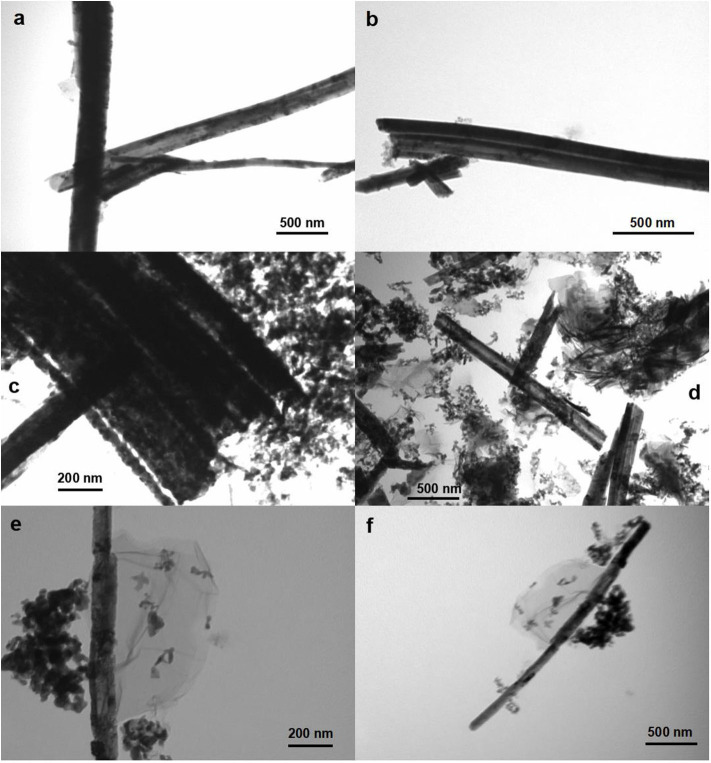
TEM images of (a) C1 (magnification of 50,000×), (b) C1 (80,000×), (c) C3 (100,000×), (d) C1g (80,000×), (e) C1g (100,000×), and (f) C1g (50,000×).